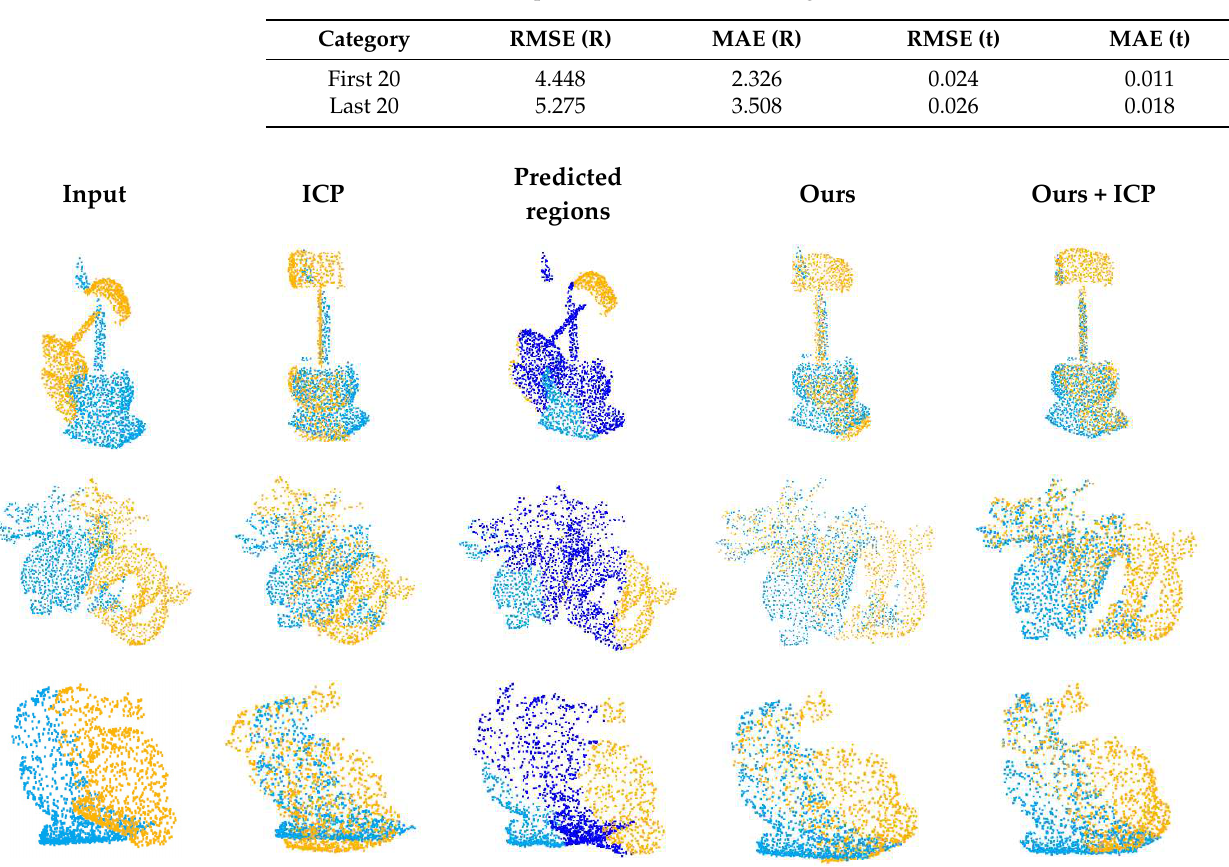
Figure 11. Example results on Stanford 3D Scan dataset. Table 3. Results of tests on point clouds of unseen categories in ModelNet40.